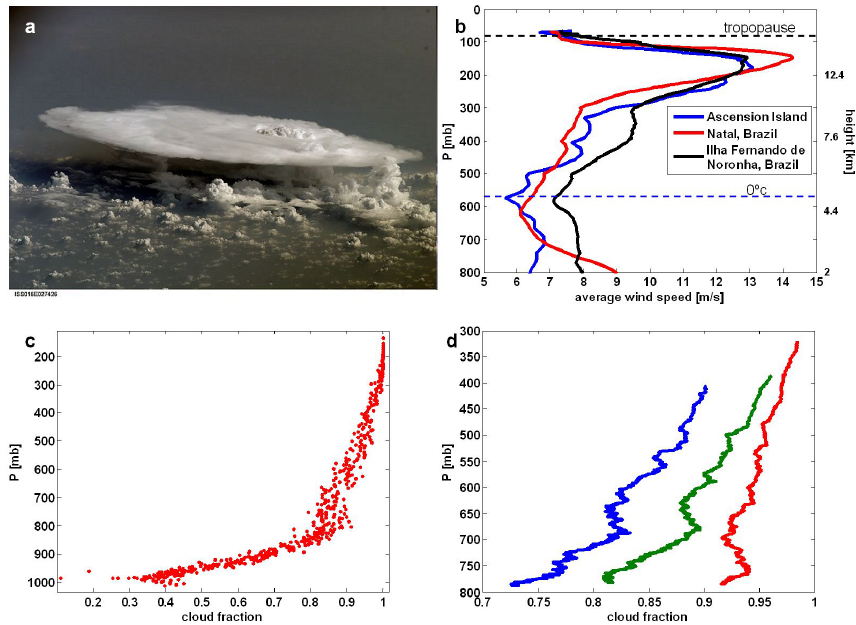
Fig. 1. (a) Photograph of a deep convective cloud with large anvil over Africa – 5 February 2008, photographed from the space shuttle (Image courtesy of the Image Science & Analysis Laboratory, NASA Johnson Space Center). (b) Monthly average daytime wind profiles measured with radiosondes at 3 stations along the tropical Atlantic: Natal, Brazil (red, 5.9 ◦ S 35.2 ◦ W); Ilha Fernando de Noronha, Brazil (black, 3.8 ◦ S 32.4 ◦ W), Ascension Island (blue, 7.9 ◦ S 14.4 ◦ W). (c) Analysis of cloud fraction as a function of the cloud top pressure (height) over the ITCZ (tropical Atlantic). (d) Focusing on the free atmosphere ( > 800hPa), cloud fraction as a function of the cloud top pressure for 3 averaged aerosol groups, AOD=0.13 (blue), 0.24 (green) and 0.41 (red), for the tropical Atlantic. Note that the pressure level ranges (height) are different for b, c and d.